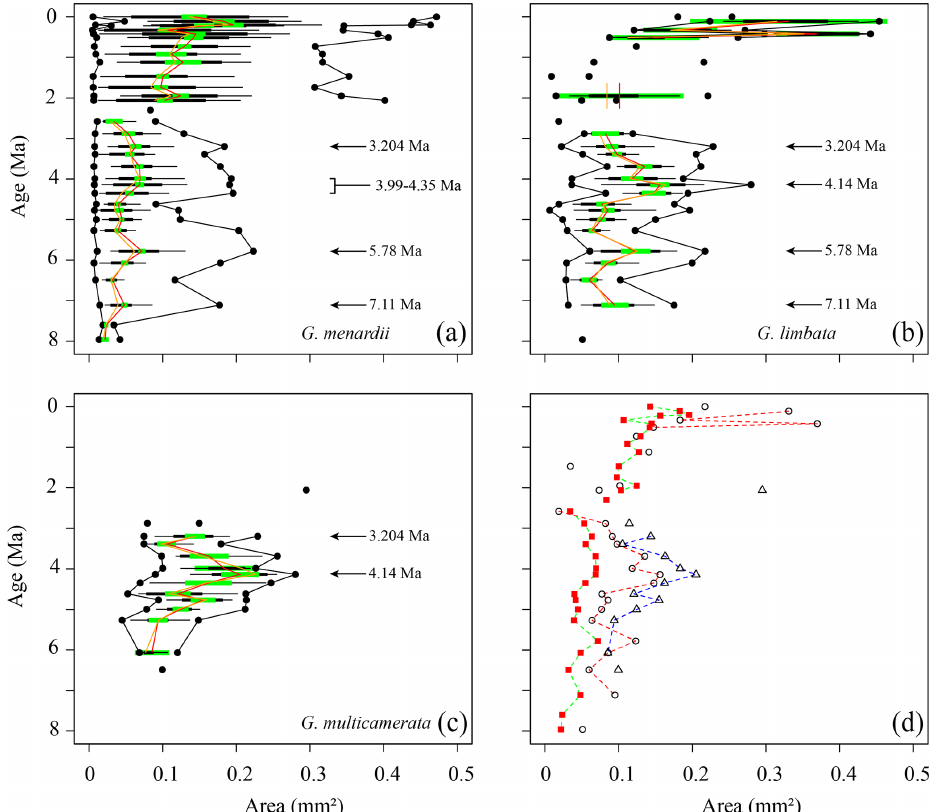
Figure 7. Test area (Ar) in keel view (inmm 2 ) versus time (Ma) at ODP Hole 667A for (a) G. menardii , (b) G. limbata , (c) G. multicamerata and (d) the mean values of the three species. See Fig. 5 for the explanation of the